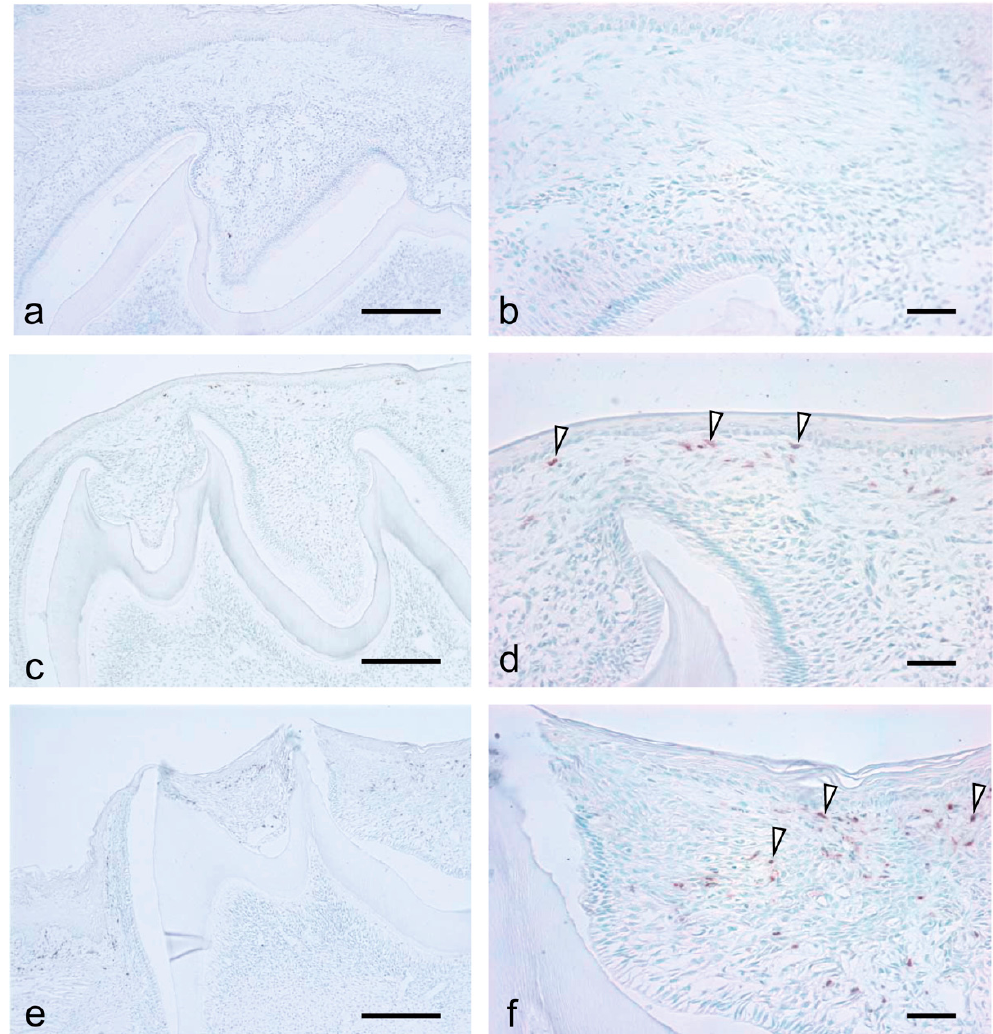
Figure 5. Localization of neutrophils during the tooth eruption at 7dPN ( a , b ), 14 dPN ( c , d ), and 19 dPN ( e , f ). No neutrophils were detected in the dental pulp in all stages. At 14 dPN, neutrophils were easily detected in the connective tissue overlying the tooth organ (( d ), arrowheads), and the number of neutrophils were increased at 19 dPN (( f ), arrowheads). Bars = 200 μ m in ( a , c , e ); 50 μ m in ( b , d , f ).